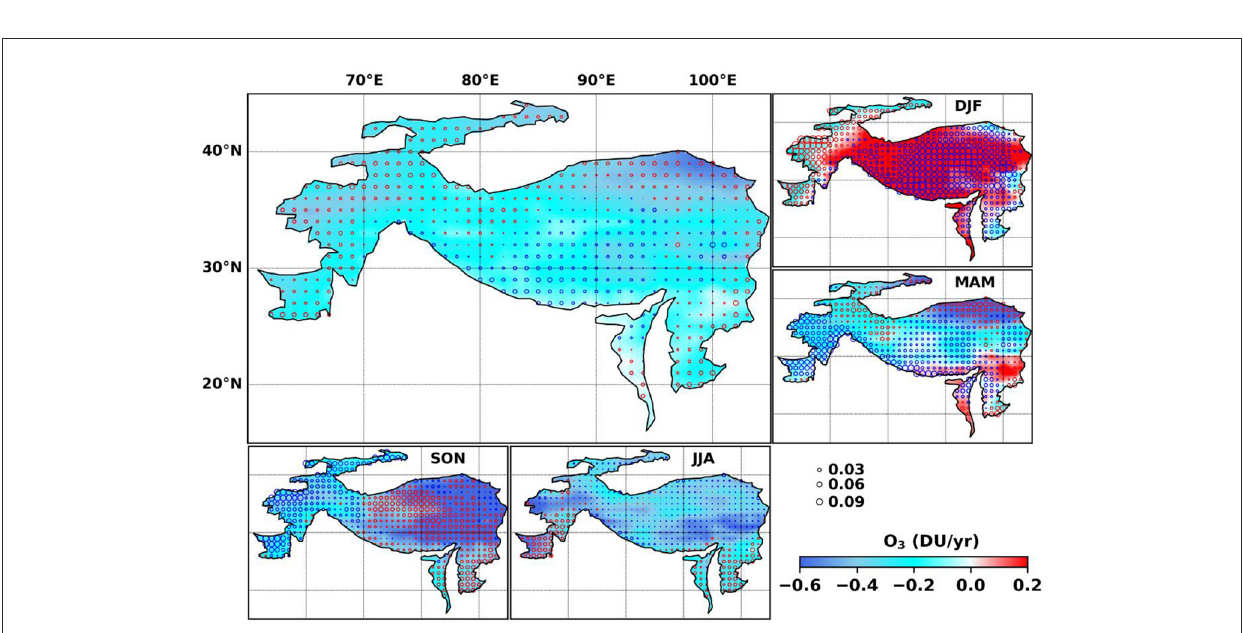
FIGURE3 Annual and seasonal trends in TCO over TP for the period 2005–2020. The seasons are defined as spring: March–April–May (MAM), summer: June–July–August (JJA), autumn: September–October–November (SON), and winter: December–January–February (DJF). The overlaid open circles show the surface temperature (1,000 hPa, from ERA5) trends. Red and blue circles denote positive and negative trends in temperature, respectively. The size of the circle represents the magnitude of the trends.